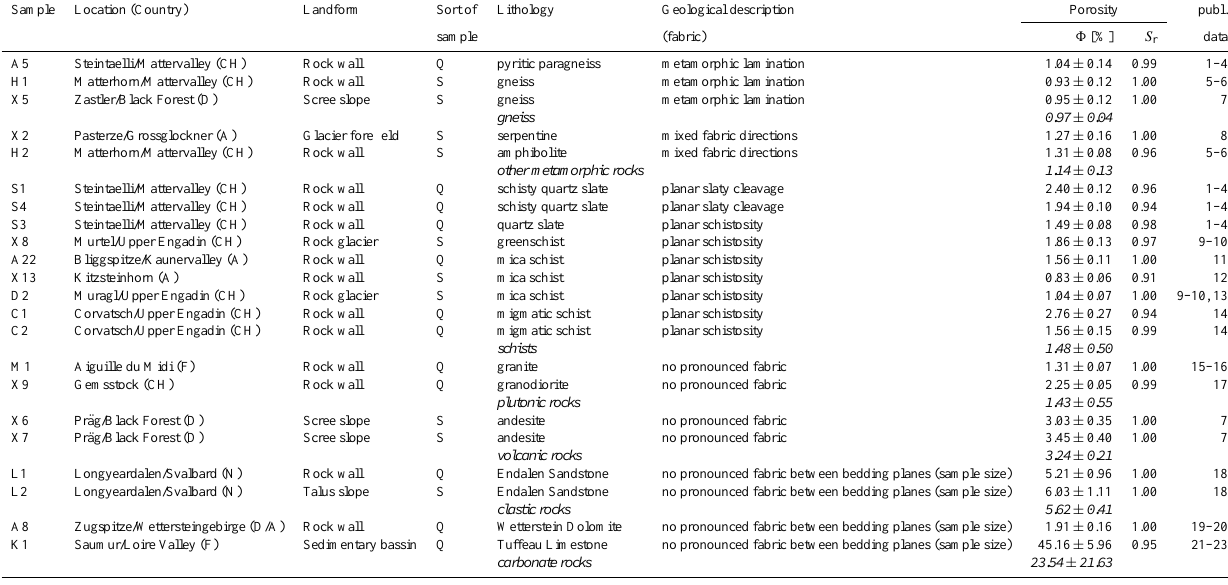
Table 1. Rock samples, source, lithology, geologic description (fabric), porosity ( 8 ) and degree of saturation ( S r ). Sample Location(Country)